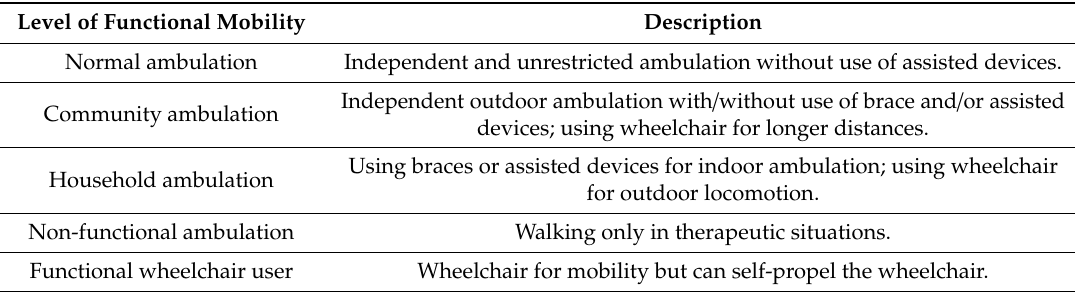
Table 2. Inclusion criteria for level of functional mobility based on Ho ff er et al. [47] and Schoenmaker’s [48] ambulation level classification, with an additional functional wheelchair